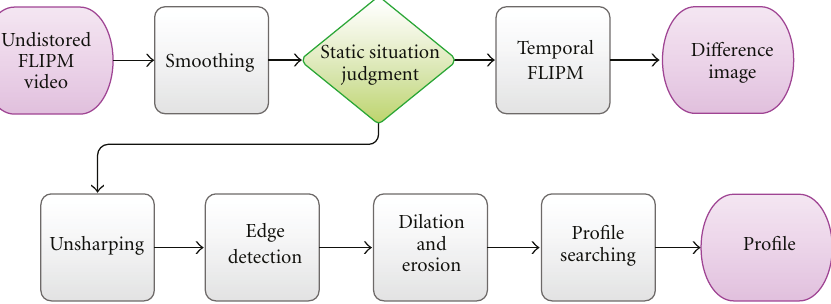
Figure 8: The flow chart of image pre-processing.